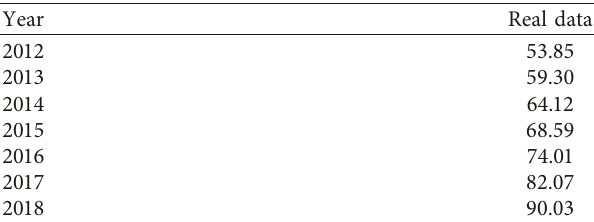
Table 4: China’s GDP from 2007 to 2018 (unit: 10 12